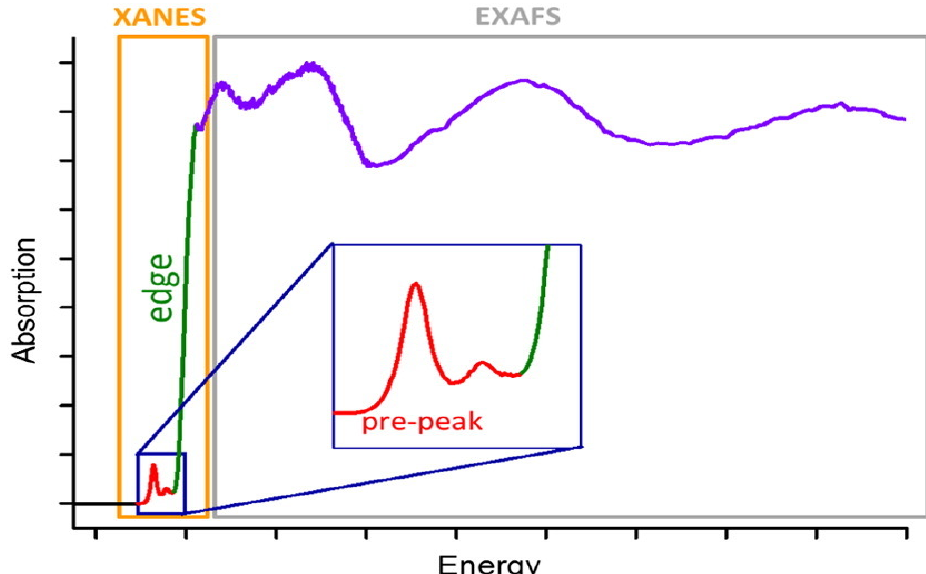
Figure 20. Composition of a XAS spectrum collected for a single edge. The near-edge region arising from inner electron ionization and the pre-peak region created by contributions from the forbidden transitions both constitute the XANES section, while the photoelectron interference-related region constitute the EXAFS region. Figure reproduced with permission from Kowalska and DeBeer [159]. Copyright (2015) Elsevier.